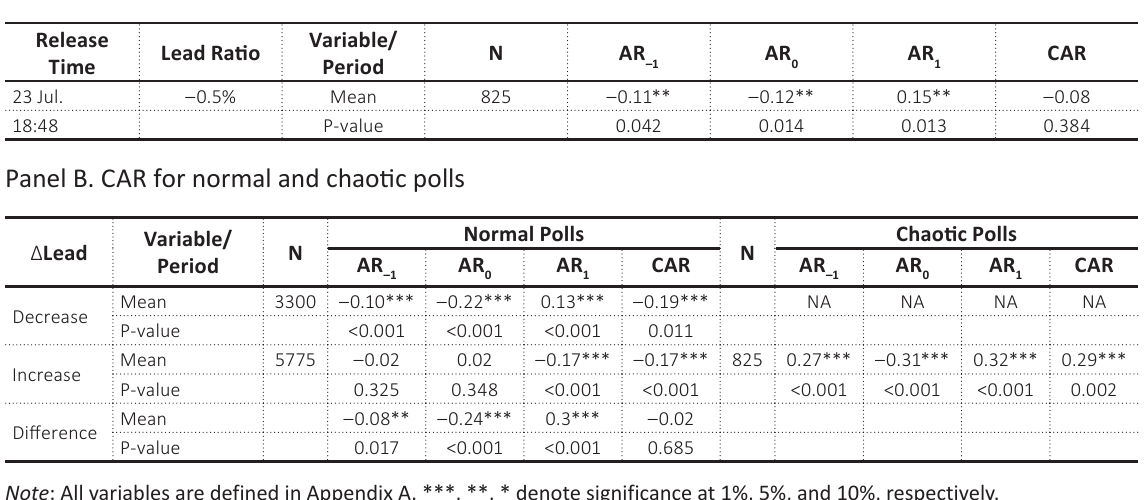
Table 3. Cumulative abnormal returns for the Apple Daily polls Panel A. CAR for initial poll